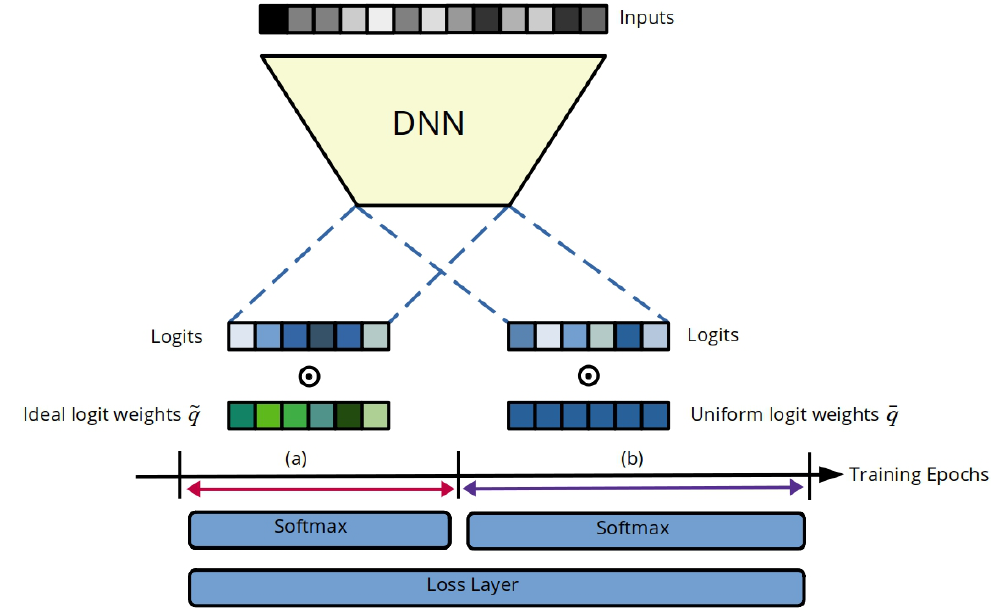
Figure 3. Model architecture: ( a ) First phase of training: ideal logit weight vector ˜ q used for logit perturbation. ( b ) Second phase of training: uniform logit weight vector ¯ q used for logit